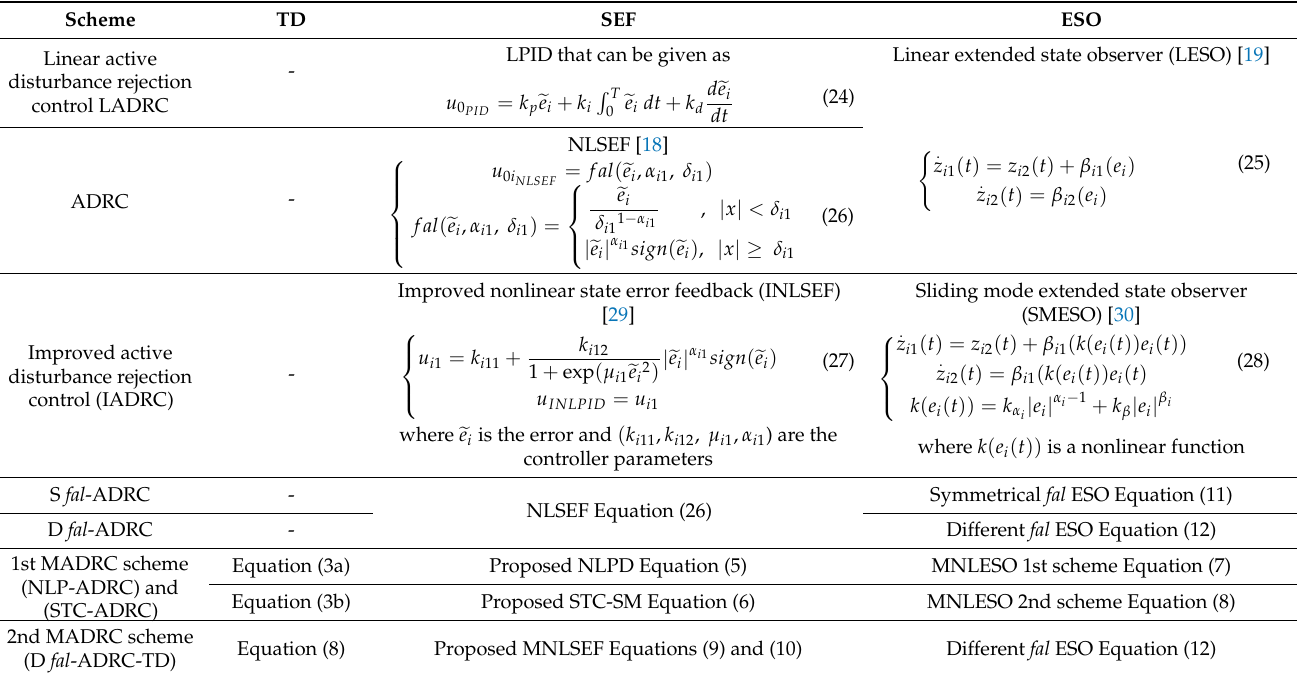
Table 5. Summary of all the proposed methods used in this